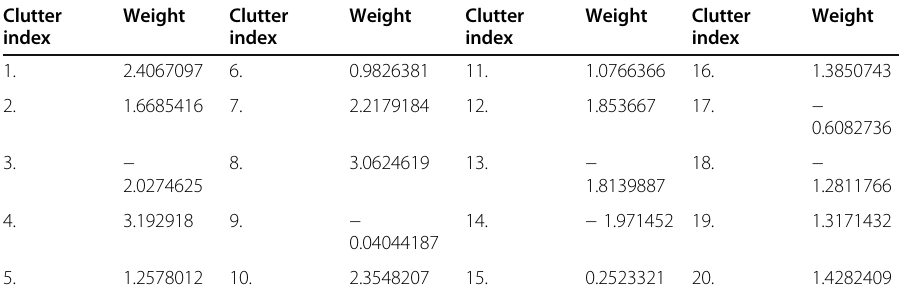
Table 9 The weight of each scene Clutter